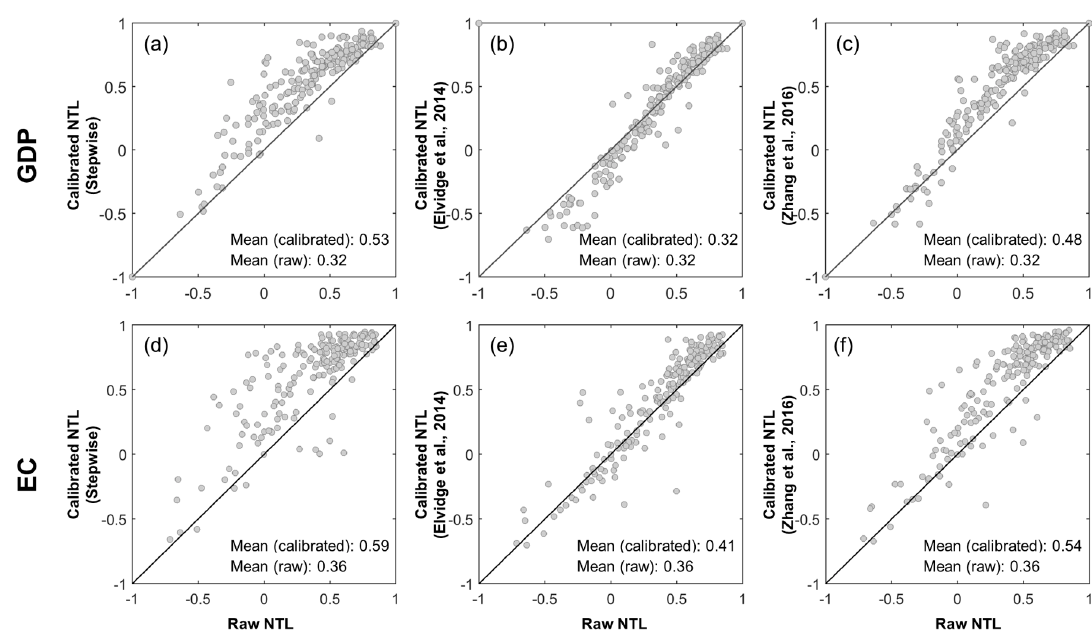
Figure 11. The correlation of Gross Domestic Product (GDP) and EC with the raw NTL and the calibrated NTL from this study ( a , d ), Elvidge et al. [17] ( b , e ), and Zhang et al. [15] ( c , f ), respectively. The black line is the 1:1 line.